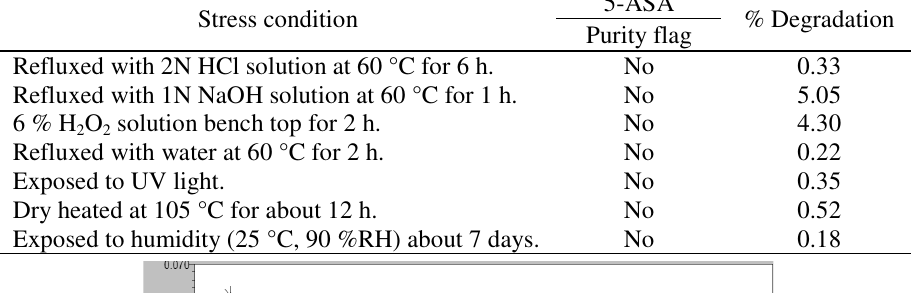
Table 4. Forced degradation data and purity results of mesalamine (5-ASA) Stress condition Refluxed with 2N HCl solution at 60 °C for 6 h. No 0.33 Refluxed with 1N NaOH solution at 60 °C for 1 h. 6 % H O solution bench top for 2 h. 2 2 Refluxed with water at 60 °C for 2 h. Exposed to UV light.